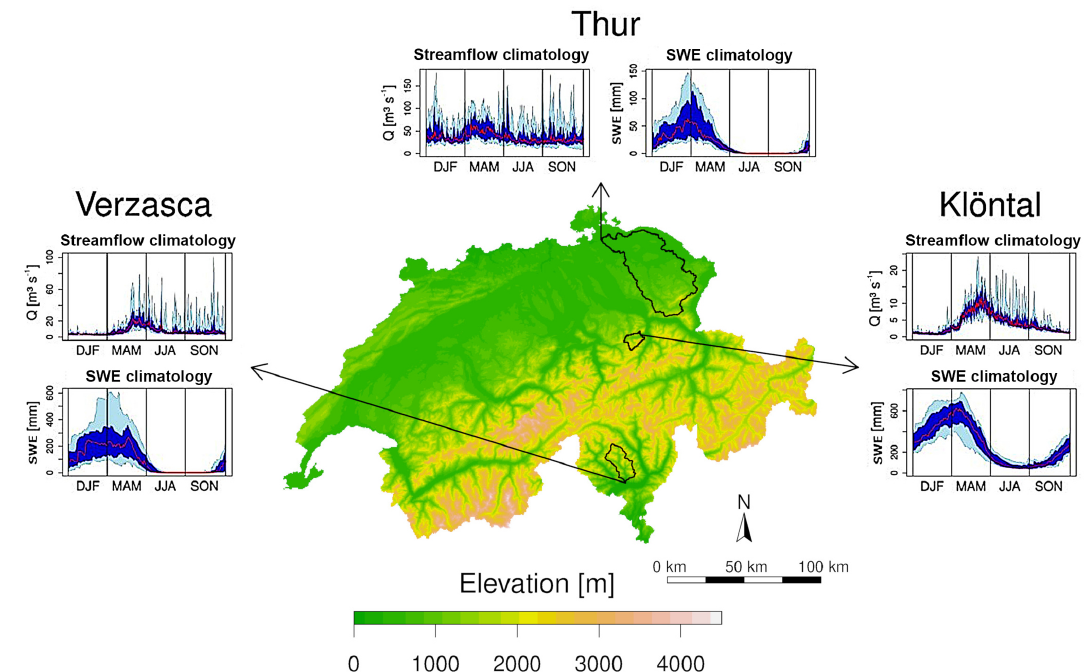
Figure 2. Location and extent of the three selected catchments and their corresponding streamflow and SWE climatology. The Verzasca catchment in the south, the Klöntal catchment in the centre, and the Thur catchment in the north-east. Table 2. Verification of the reference simulation with corresponding observations for the Verzasca catchment, the Klöntal catchment, and the Thur catchment. In each catchment the NSE, the NSE log, the bias, and the mean absolute error are shown. The verification is done for the full simulation period (FullYear: 1994–2014) and the individual seasons within the full period (DJF, MAM, JJA, SON). A perfect simulation would have NSE = 1, and positive values of NSE indicated better skill than the reference